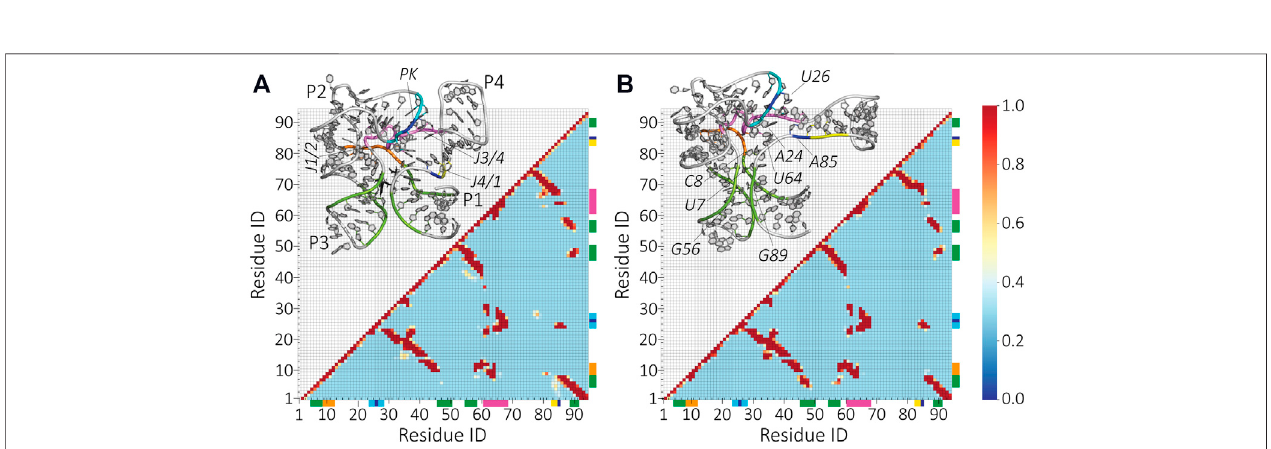
FIGURE 5 | Contact formation frequency between the residues upon the removal of the ligand molecule SAM. Contact map of (A) the ligand-bound (s1) and (B) ligand-free (s2) SAM-I riboswitch. The map is based on a 6-Å cutoff for the minimum distance between the residues. Interhelical residues that get closer upon removing the ligand are highlighted with green and cyan/blue bars. The junctions J1/2, J3/4, and J4/1 are colored in orange, magenta, and blue-yellow, respectively. The same color scheme is applied in the inserted structural representation to illustrate the location of these contact